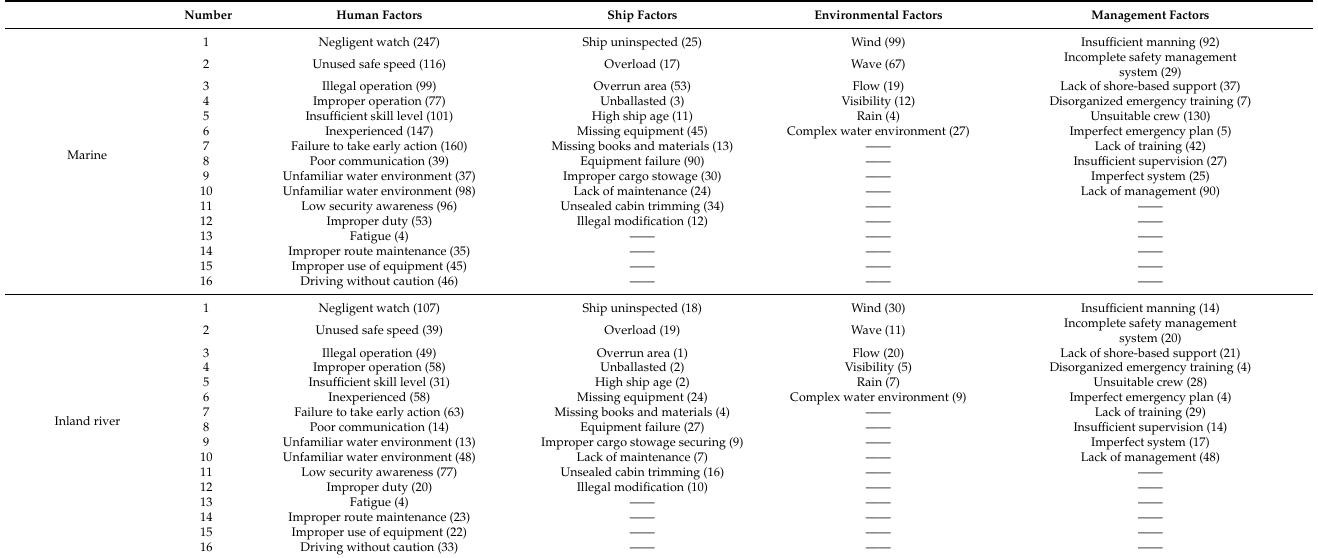
Figure 5. Proportion of various risk factors in the marine and inland rivers. Table 2. Numbers of sub-factors of marine and inland river risk